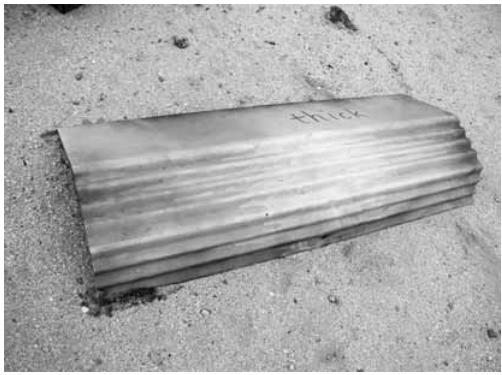
Fig. 25. Outside view of thick shield after test.